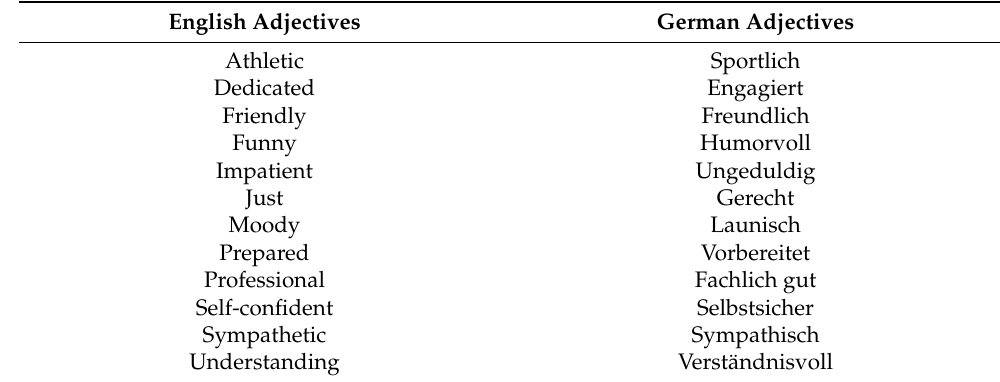
Table 1. Pool of adjectives describing physical education teachers’ characteristics included in the tested structural